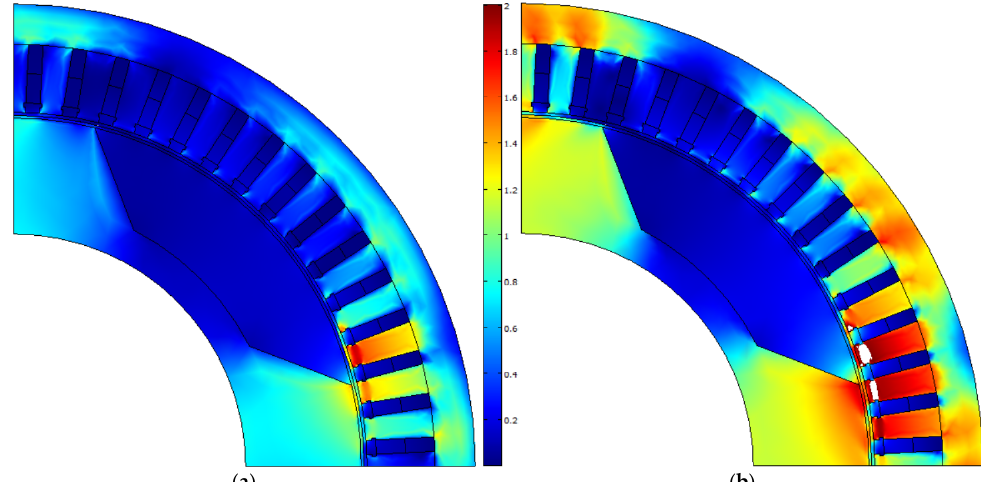
Figure 10. The cross-section of the optimized design of the synchronous homopolar motor and the magnitude plot of flux density (T); white areas mark the extreme saturation level (>2 T). ( a ) Operating point 1; ( b ) operating point 4.